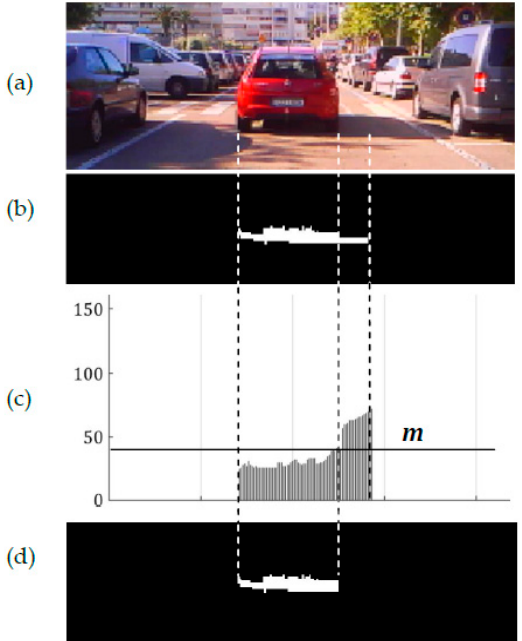
Figure 3. Intensity thresholding of the cluster of gradients under a vehicle in Figure 2 right. ( a ) Incoming image, ( b ) cluster of gradients due to both shadow under the vehicle and lateral shadow, ( c ) intensity of upper pixels of the cluster, and ( d ) resulting cluster after refined intensity thresholding.